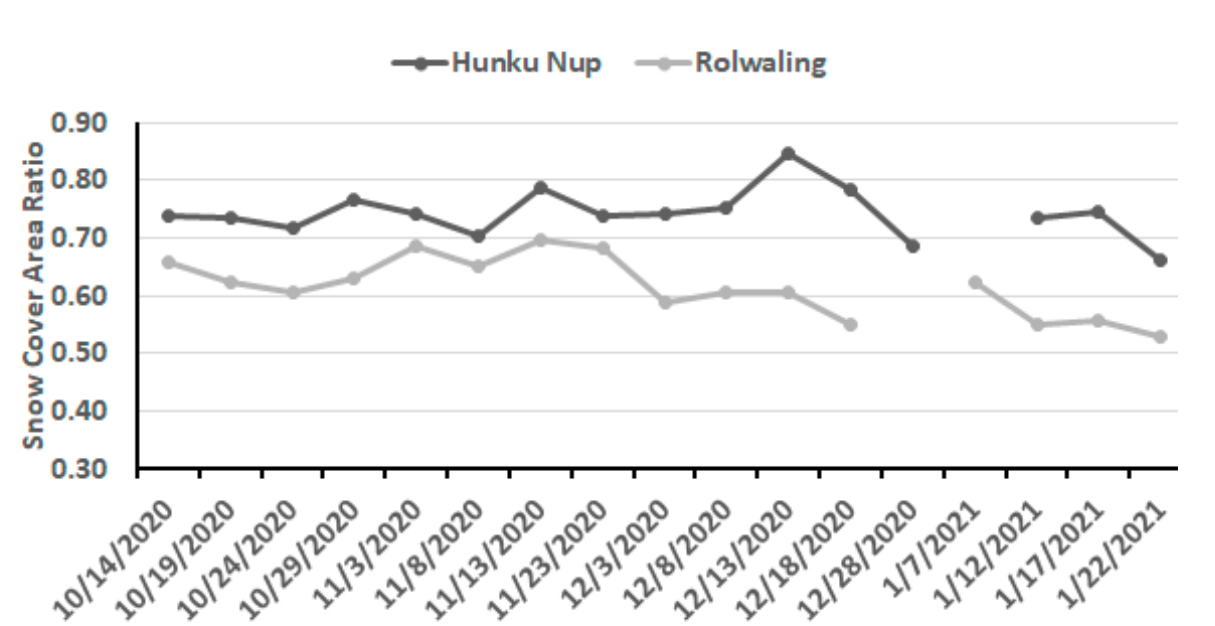
Figure 6. Snow covered area on Hunku Nup Glacier and Rolwaling Glacier in Sentinel-2 imagery from 14 October 2020 to 22 January 2021.